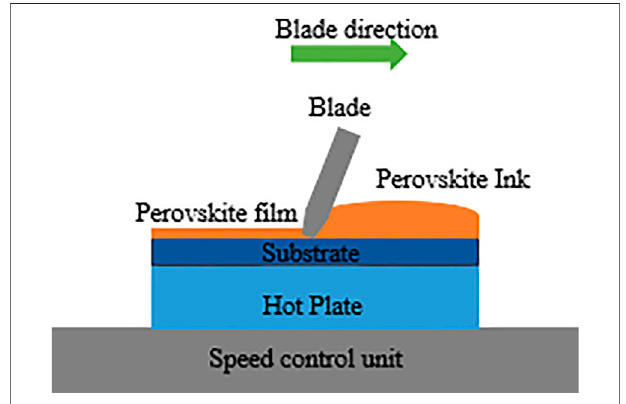
FIGURE 7 | Schematic of perovskite fi lm fabrication through doctor- blade coating.